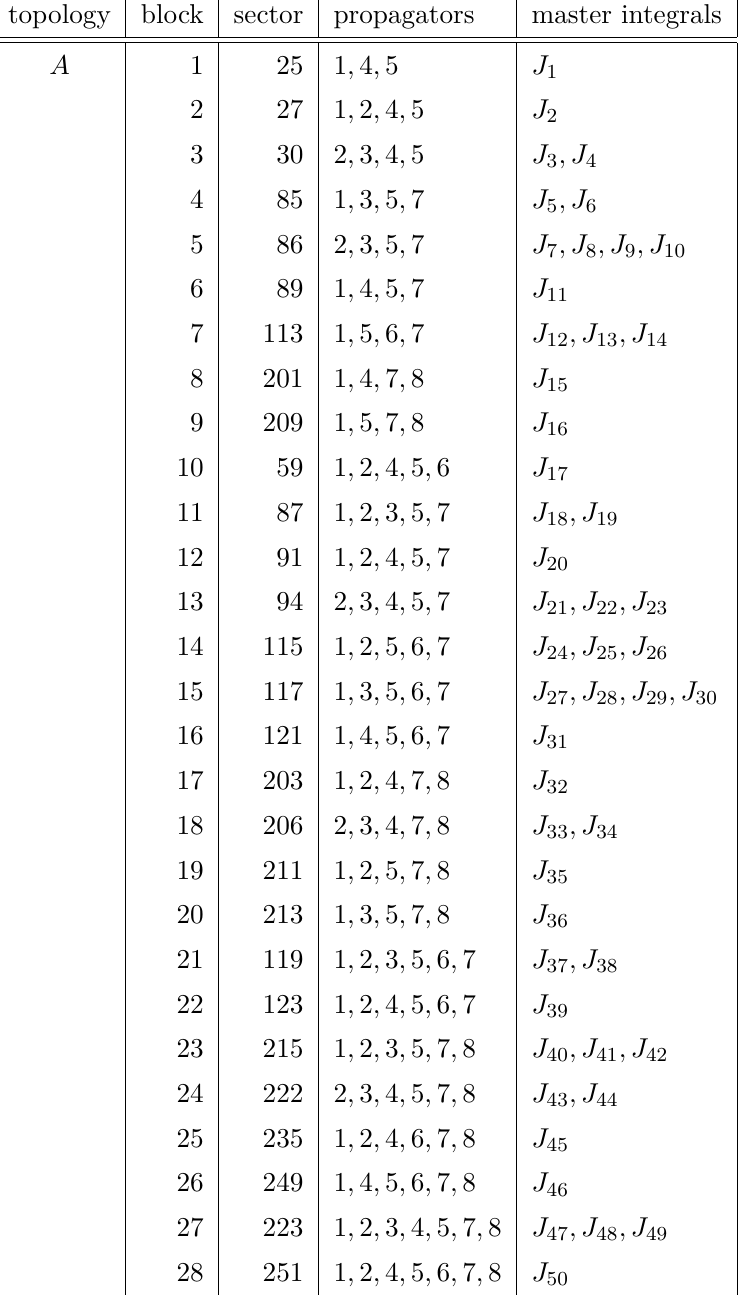
JHEP11(2022)051